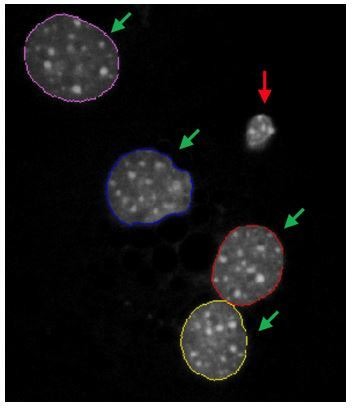
Image of DAPI-stained mouse hepatocytes showing segmentation of normal healthy nuclei (green arrows), but not of pyknotic or pre-pyknotic nuclei (red arrow).